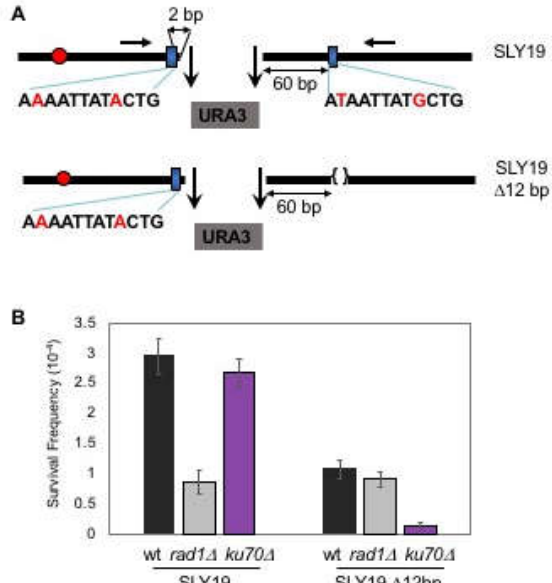
Figure 1. Microhomology selection for microhomology-mediated end joining (MMEJ) is non-random. ( A ) Two homothallic switching endonuclease (HO) cleavages at the MAT locus (the 117-bp MAT a and the full-length MAT α cut sites) separated by ∼ 2 kb of URA3 sequence preferentially induced Ku and RAD52 -independent Microhomology-mediated end joining (MMEJ) using the flanking 12-bp of imperfect microhomology that was 2-bp and 60-bp away from the break. The location of the centromere (red circles) and the preferred microhomology (blue boxes) for MMEJ are shown. The sequence (mismatches are shown in red characters) of the preferred microhomology are shown below the blue boxes. The positions of the primers for PCR amplification and sequencing are shown by red arrows. ( B ) Survival frequency after induction of HO breaks of the wild type (WT), the RAD1 gene deleted [ RAD1 Δ representing the frequency of classical non-homologous end joining (C-NHEJ)], and the KU70 deletion derivatives ( ku70 Δ, the frequency of MMEJ) of SLY19 or SLY19 lacking preferred 12-bp imperfect microhomology (SLY19 Δ12-bp). The frequency of survival after an HO-induced double strand breaks (DSB) was calculated by dividing the number of colonies growing on YEP-agar medium containing galactose (YEP–GAL) by the number of colonies growing on YEP-agar medium containing glucose (YEPD). Each value represents the average from at least three independent experiments ± standard deviation.